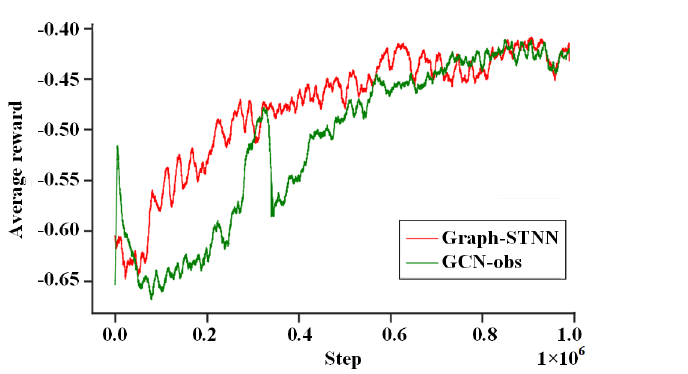
Figure 9. The training performance of Graph-STNN and GCN-obs in our setting with the size of 20 m × 20